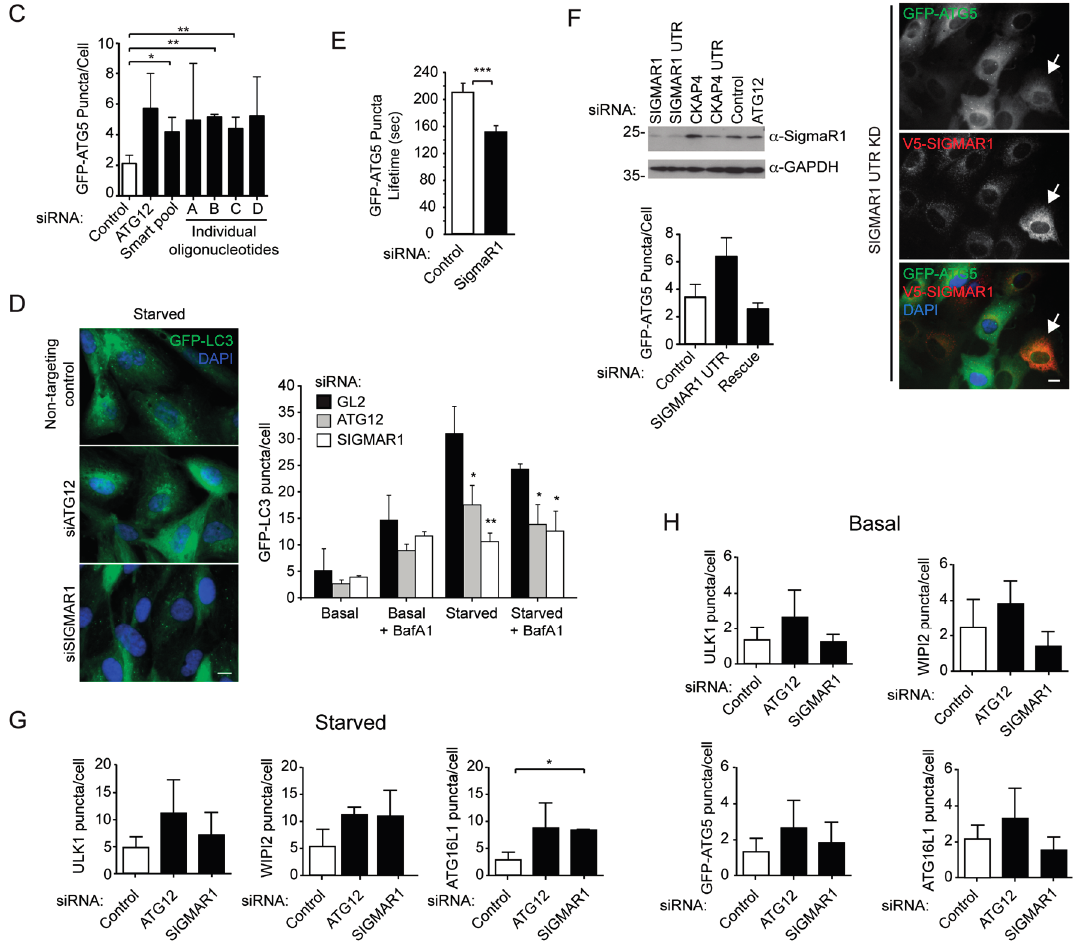
Figure 2. SIGMAR1 suppression blocks autophagy at the isolation membrane expansion/ LC3 lipidation stage. ( A ) Pooled data from the combined GFP-ATG5 and GFP-LC3 autophagy screen. Each green diamond represents a single siRNA target. Those with red outlines are identified. A red diamond shows the theoretical mean. The red box represents the cut-off values for positive hits; ( B ) Further characterisation of potential hits using GFP-ATG5 puncta quantitation in starved cells (example images to the left; quantitation to the right); ( C ) Deconvolution of the SIGMAR1 SMARTpool by analysis of GFP-ATG5 puncta in starved cells; ( D ) Reduced LC3 puncta in SIGMAR1-suppressed cells. Example images to the left, quantitation of >400 cells/condition across n = 3 experiments are shown to the right; ( E ) Destabilised GFP-ATG5 puncta in SIGMAR1-suppressed cells. Puncta lifetimes measured in GFP-ATG5 RPE1 cells subjected to starvation; ( F ) Rescue of the SIGMAR1 suppression effect using V5-tagged SIGMAR1. An immunoblot of the efficiency of suppression of SIGMAR1 using an oligonucleotide targeting the 3 ′ untranslated region (UTR), alongside example images of cells suppressed for endogenous SIGMAR1 and expressing V5-SIGMAR1. Quantitation of the rescue based on GFP-ATG5 puncta counts in starved cells is also shown; Arrows indicate an example transfected cell; ( G , H ) Measurements of ULK1, WIPI2 and ATG16L1 puncta in SIGMAR1-suppressed cells under basal ( G ) and starvation (H) conditions. *** p < 0.001; ** p < 0.01; * p < 0.05 one-way ANOVA, Tukey’s post -test. Scale bars = 10